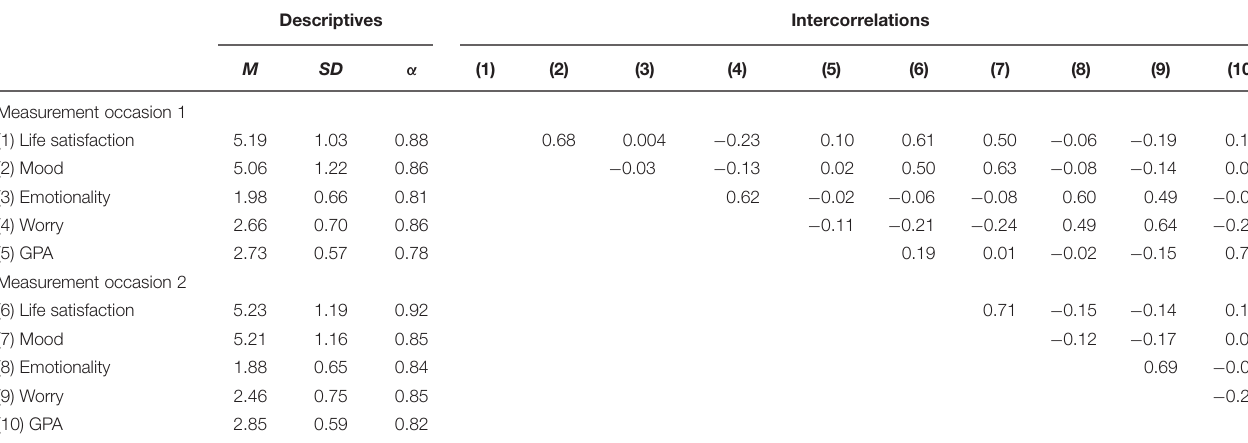
2 but mood level at measurement point 1 did not predict change in worry (Model 5). No reciprocal effects were found between emotionality and mood level (Model 4) and between GPA and mood level (Model 6). Emotionality at measurement point 1 did not predict change in GPA and GPA at measurement